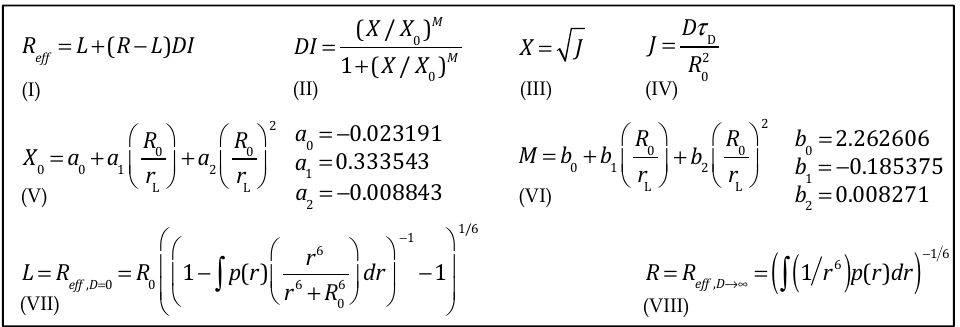
Table 2. X 0 and M as second-degree polynomial functions of R 0 / r L .